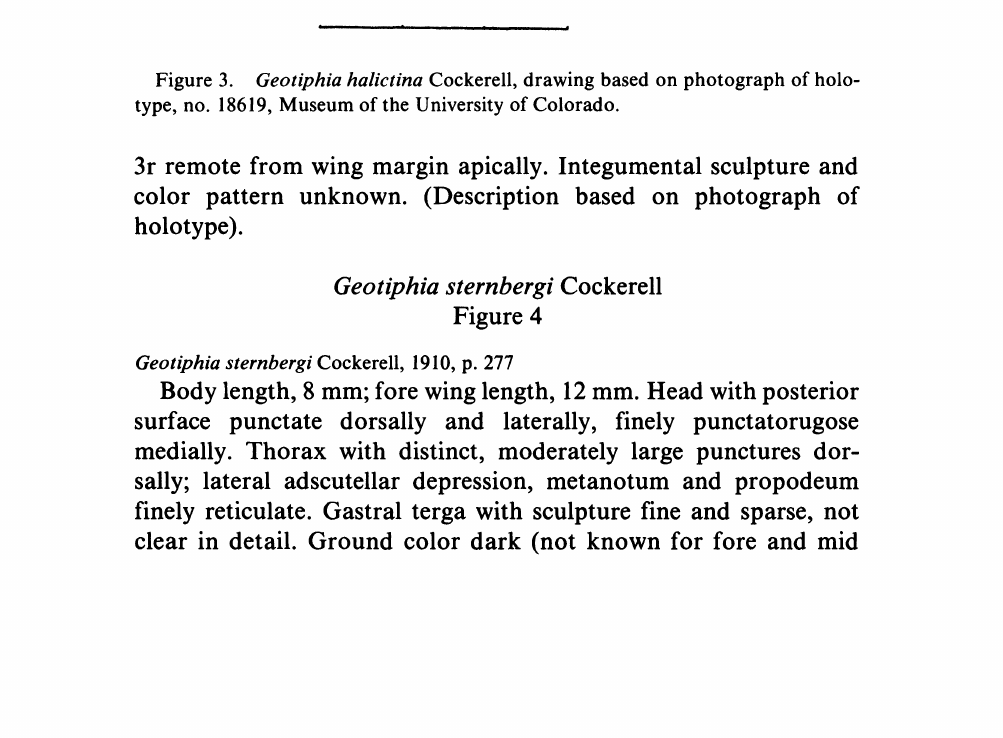
Figure 3. Geotiphia halictina Cockerell, drawing based on photograph of holo- type, no. 18619, Museum of the University of